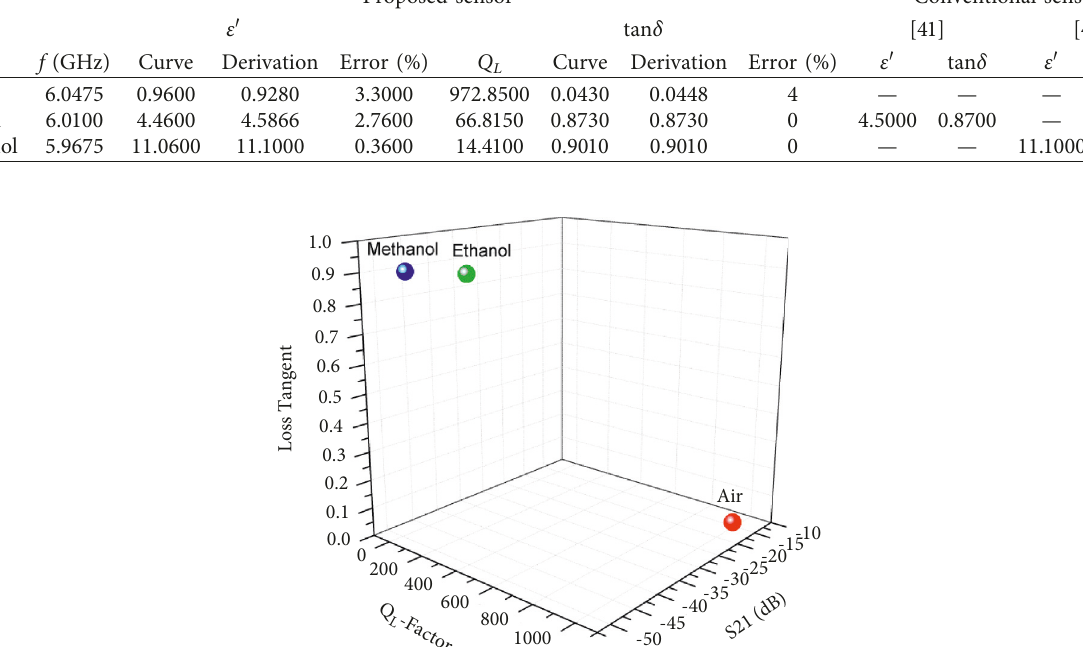
L -factor, and transmission coefficient.